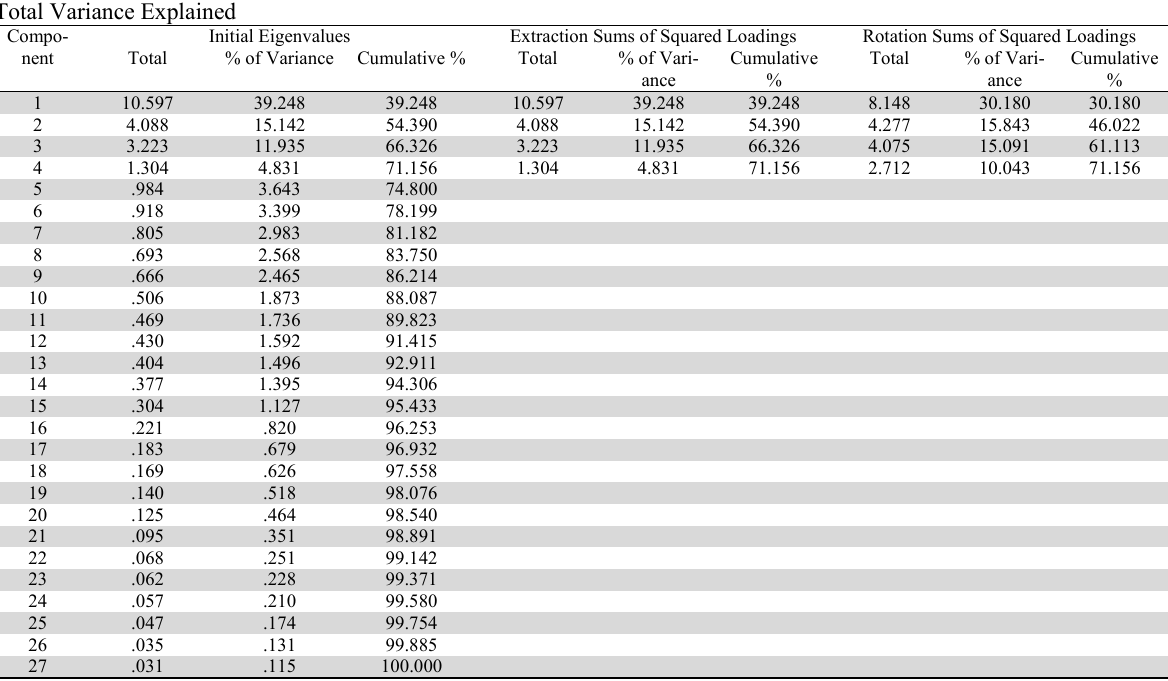
Extraction Method: Principal Component